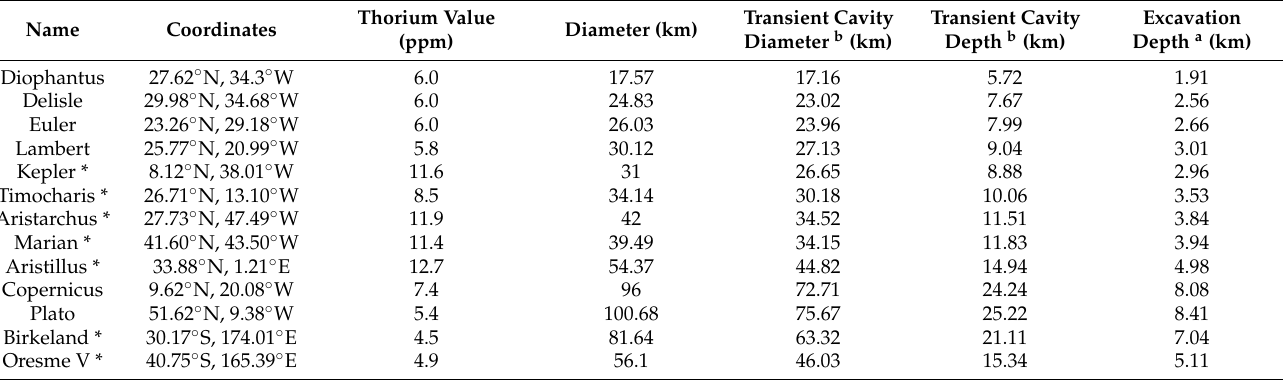
Table 1. Impact craters